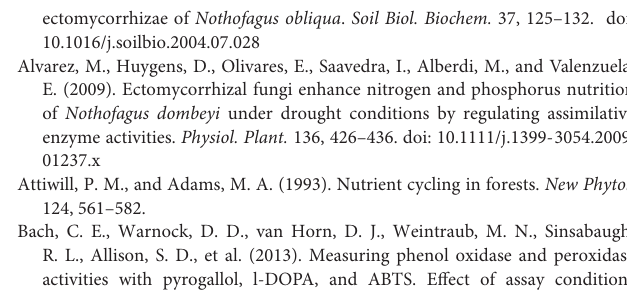
FIGURE S2 | (A) Microbial and (B) bacterial biomass based on PLFA-analysis in the open and closed IGTs in Bad Brückenau (BBR), Mitterfels (MIT), Vessertal (VES), Conventwald (CON), and Lüss (LUE) after 18 months of exposure ( n = 5). Forests sharing no letter are significantly different and asterisks highlight significant differences between open and closed IGTs at the respective forest site. TABLE S1 | Results of the nlme-Model for the IGTs in Bad Brückenau (BBR), Mitterfels (MIT), Vessertal (VES), Conventwald (CON), and Lüss (LUE), including all